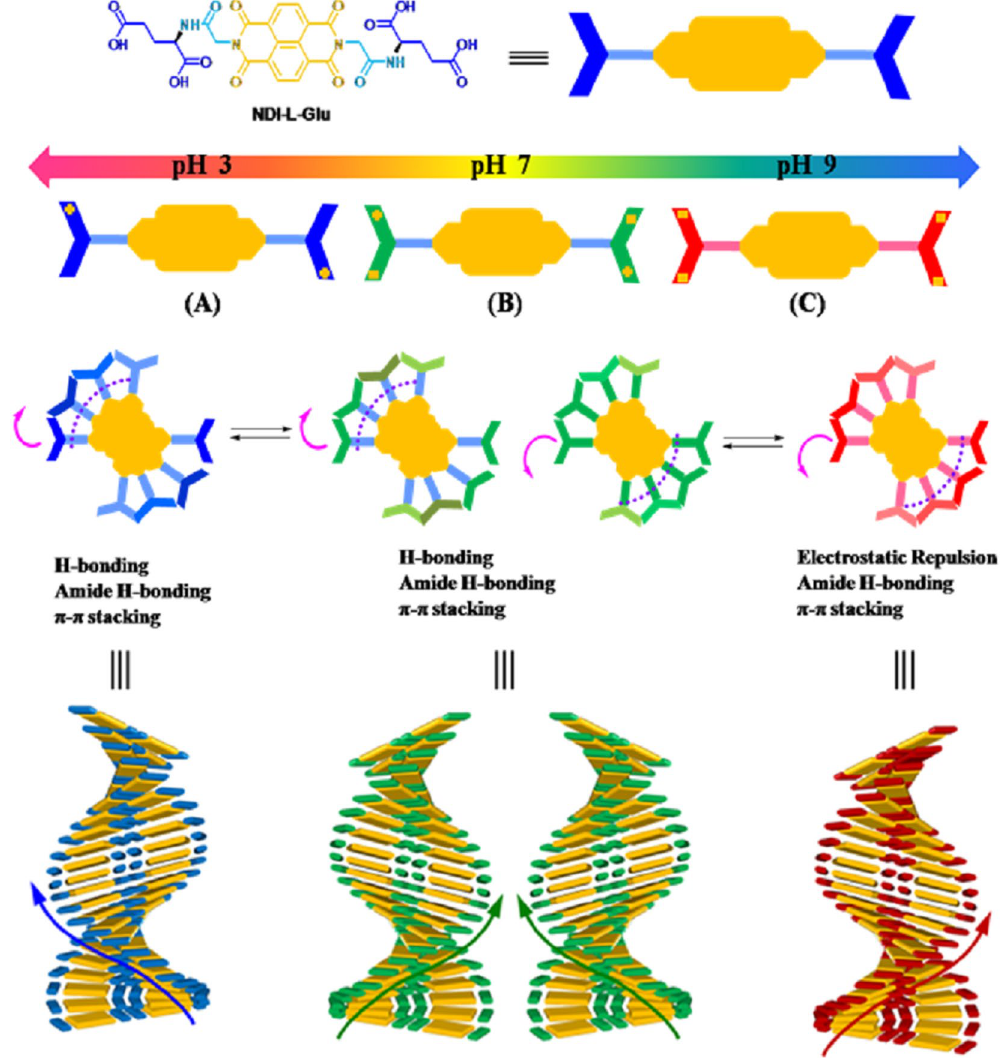
Figure 1. Schematic representation of NDI-L-Glu (1) aggregation pathways, showing the stacking of dimers bound using two hydrogen bonds at ( A ) acidic pH resulting in left-handed helix, ( B ) the self-assembly of 1 in the range of physiological pH which is initiated by both left- and right-handed oligomers due to the equilibrium between these two conformations at the molecular level, resulting in both left- and right-handed twisted superstructures, and ( C ) alkaline pH which resulted in right-handed helical superstructures. This morphology dependency of these self-assemblies on pH shows the importance of the hydrogen bonding between two molecules of 1 among other interactions in the self-assembly process. The conformation of 1 changes dihedral angular twist direction resulting in opposite direction helical